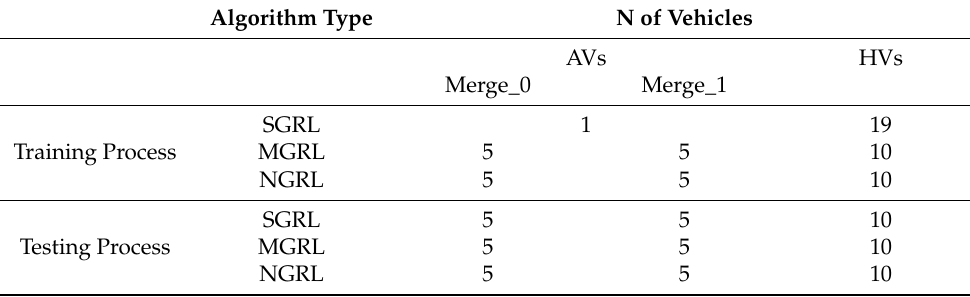
Table 2. Number setting of experimental vehicles.